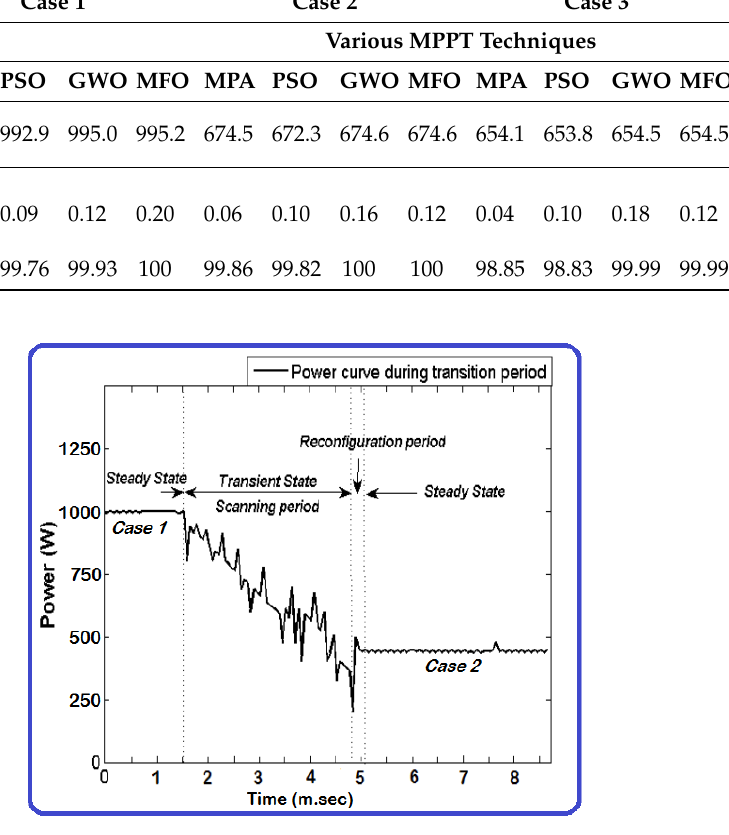
Figure 11. Experimental results of the transient condition from case 1 to case 2. Table 3. Comparison between MPA, PSO, GWO, and MFO techniques for different test cases.